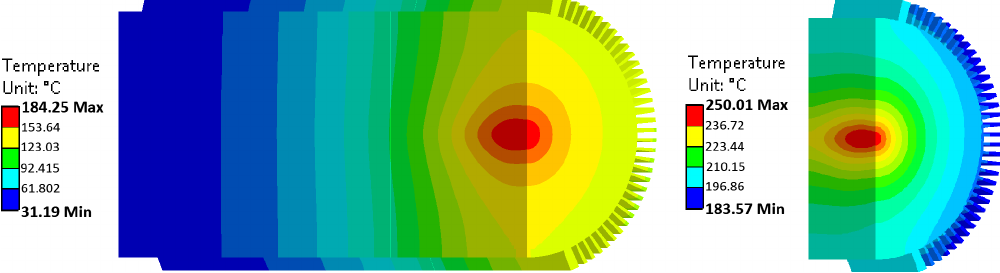
FIG. 12. Steady state temperature distributions achieved in the dump core for the two considered models under prolonged dumping of a 2 GeV NORMGPS beam with an intensity of 1 × 10 14 ppp at a 100% dumping rate. On the left, the continuous dump model. On the right, the model with the first block isolated. Temperatures in °C.